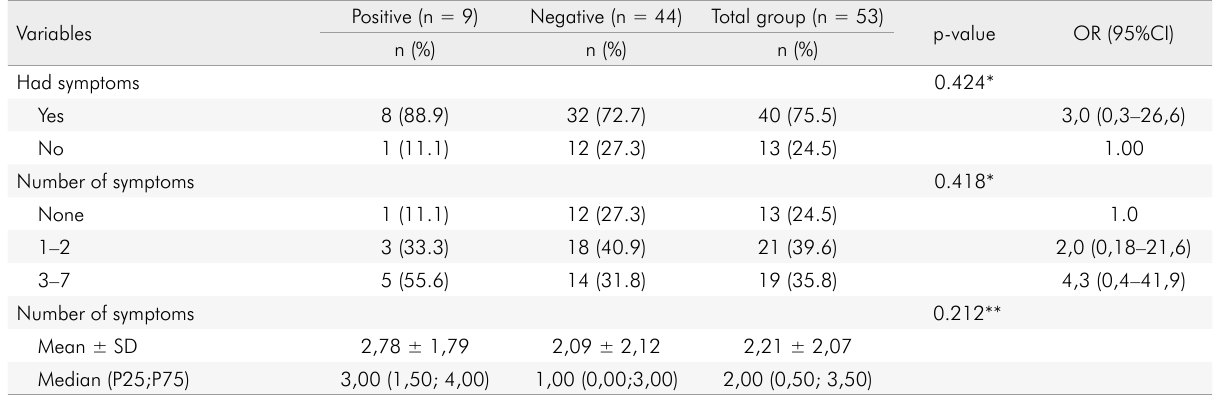
Table 4. Prevalence of symptom s and serological test results for